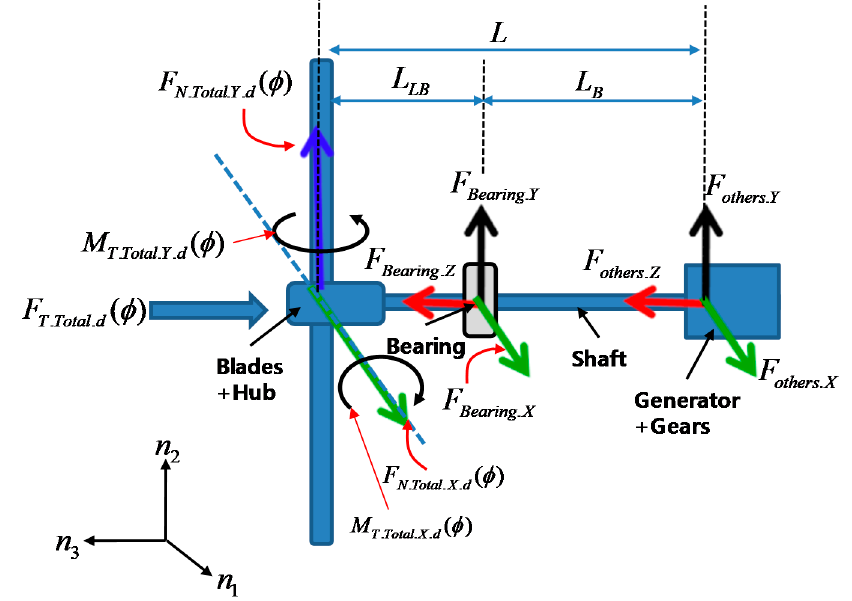
Figure 5. Free Body Diagram (FBD) of the blades–rotor–bearing-geared generator integrity. With respect to